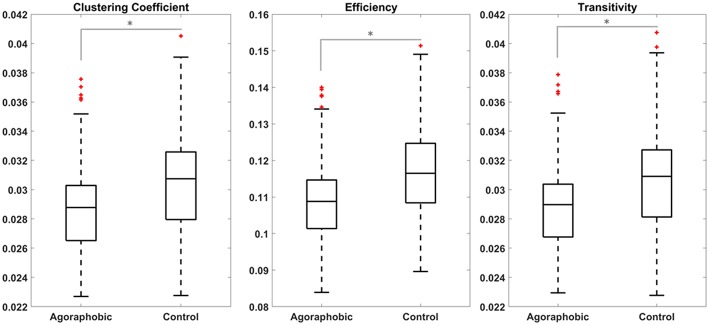
Global clustering coefficient, efficiency, and transitivity were lower in patients with subclinical agoraphobic compared to controls. Figures show the median value (line), quartiles (boxes) and extremes (whiskers) of the three metrics for the agoraphobic and control groups. Comparison between the two subjects groups were performed through non-parametric Mann-Whitney U tests.